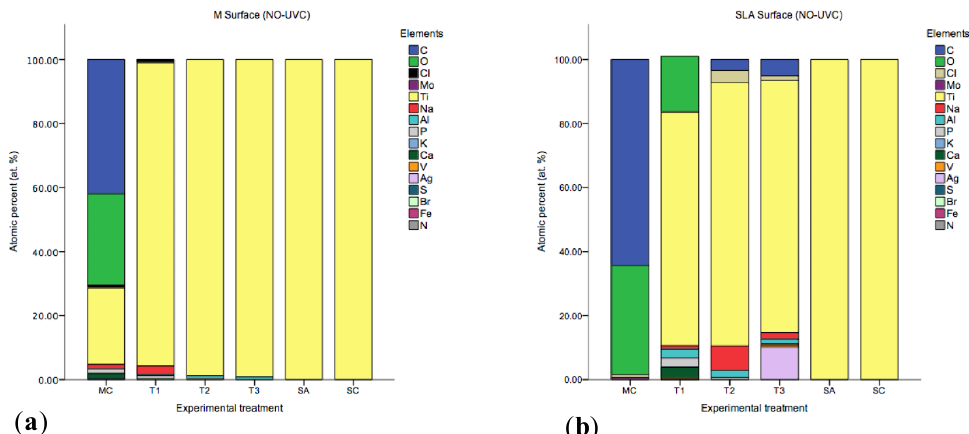
Figure 4. Results of SEM/EDX analysis, overview on mean atomic percentage (at. %) of elements on Machined ( a ) and SLA ( b ) implant surfaces before (MC, SA, SC) and after (T1, T2, T3) disinfection.